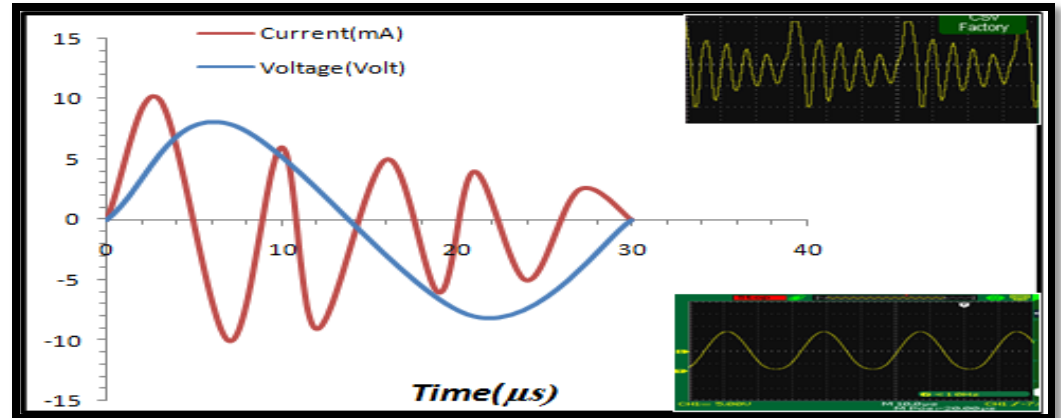
Fig.5: Voltage and current waveform for measured the power.